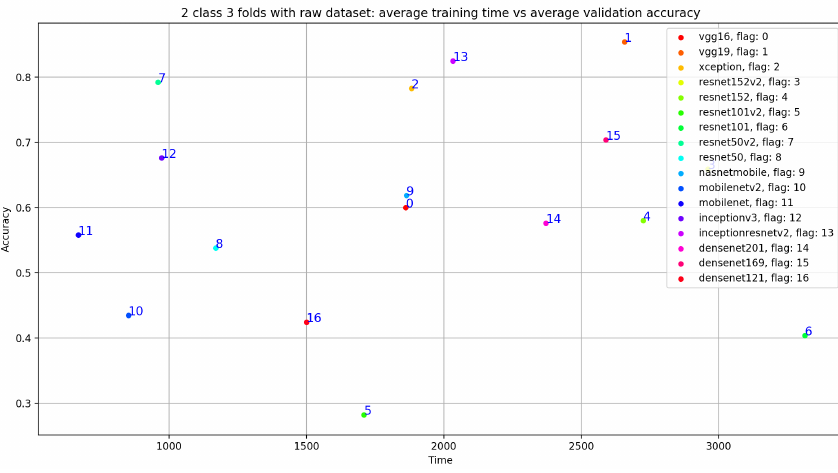
Figure 20. Training time vs. validation accuracy using raw